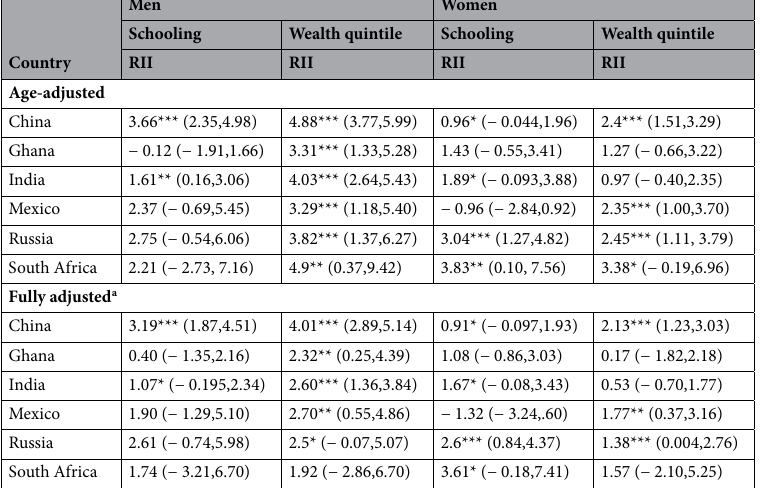
Table 2. Relative Index of Inequality in handgrip strength by years of schooling and wealth quintile among older adults aged 50+, WHO-SAGE Wave 1 (2007/10). CI confidence interval. a Regression analyses were adjusted for age, place of residence, BMI, work status, self-rated health and multimorbidity. ***p < 0.001, **p < 0.005, *p <